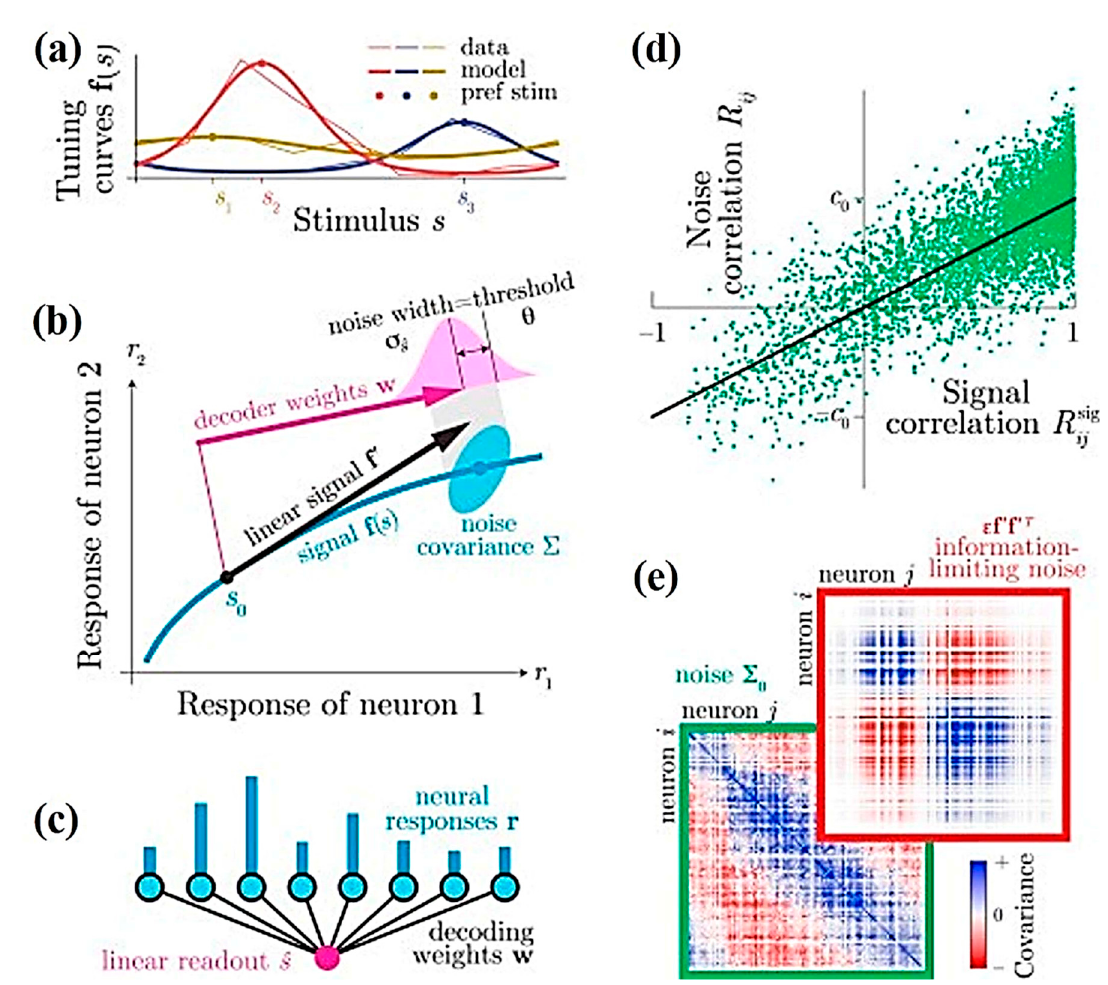
Figure 1. Model for neural responses and decoding: ( a ) tuning curves f(s) showing the mean neural responses to a stimulus s (thin lines), curve from the von Mises functions (thick curves) model with parameters including the preferred stimulus s k (dots). ( b ) The relationship of two neurons generalizing to high-dimensional response spaces under varying stimulus s. ( c ) Linear decoding projects the neural responses, both noise and signal, towards a specific direction w for the estimation of ŝ of the stimulus. ( d ) The phenomenon of showing neurons having similar tuning has higher correlated fluctuations. Noise correlation coefficients R ij between distinct neurons i and j are modeled as being proportional on average to the signal correlations Rijsig, with proportionality c 0 . ( e ) Two components to the noise covariance Σ : information-limiting correlations are distinguished; present along the signal direction f ′ and therefore show covariance ε f ′ f ′ T (front, matrix boxed in red), and the remaining noise with covariance Σ 0 (back, the matrix in the green box). The two types of noise show distinctive structures; apparent in the covariance matrices. The striations in the matrices correspond to the heterogeneous tuning curve amplitudes. Reprinted with permission from the authors of [50].